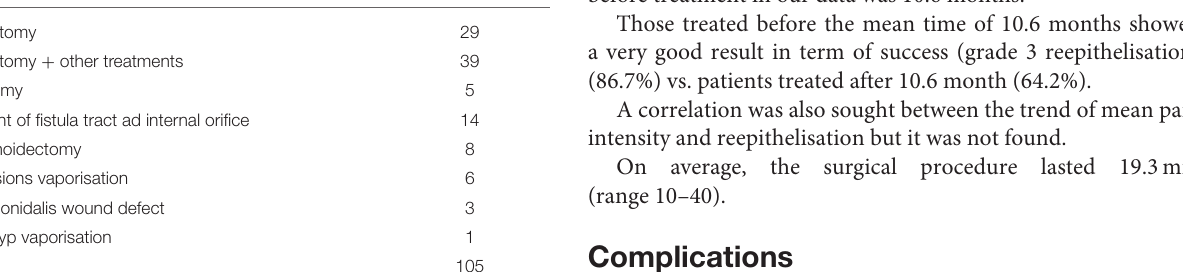
TABLE 2 | Scanner CO 2 laser proctological procedures. Surgery